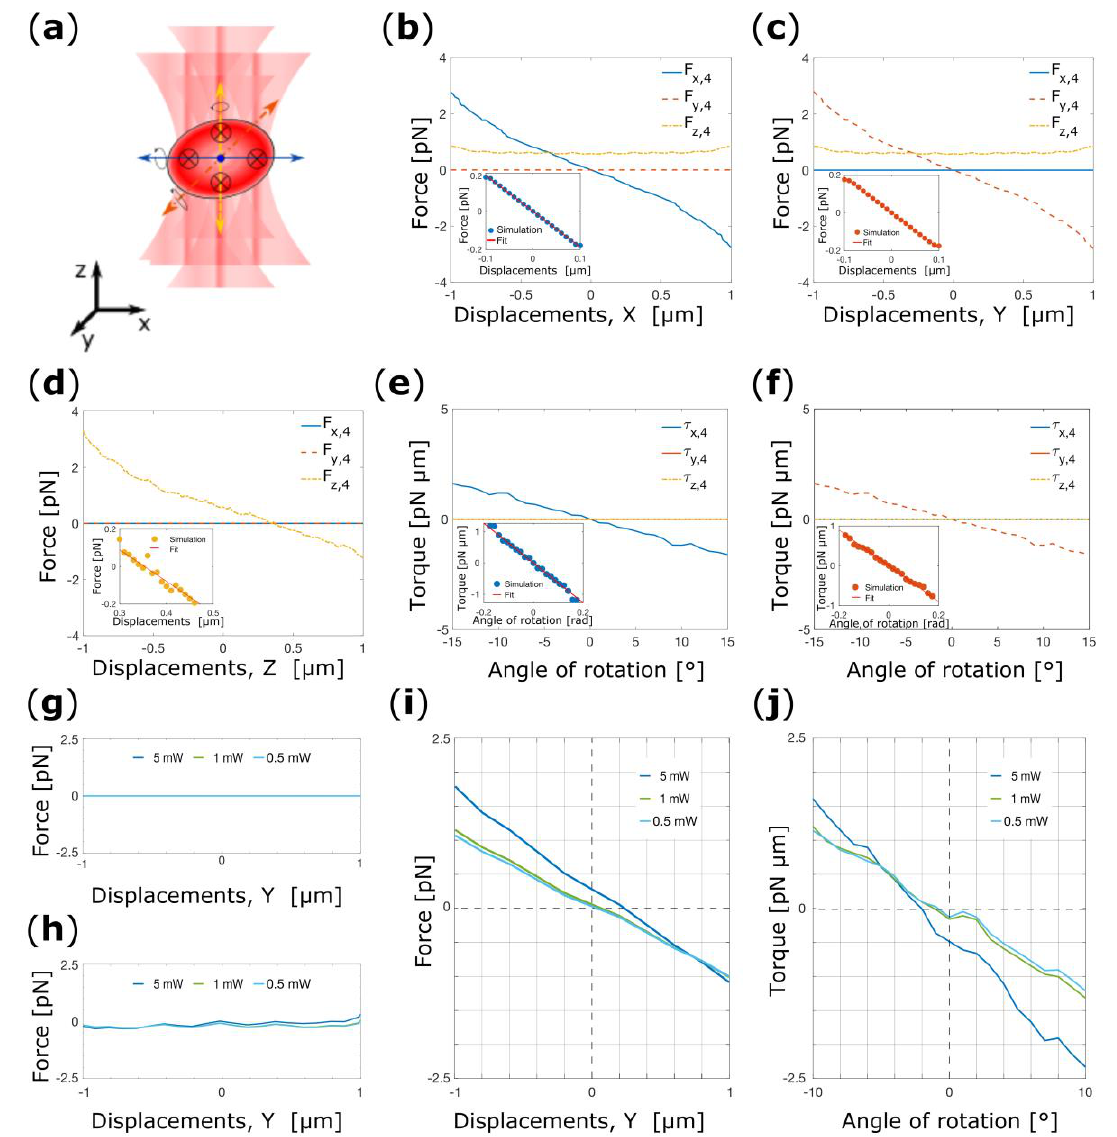
Figure 6. ( a ) Schematic representation of four beam OT. The arrows indicate the possible translations and rotations of the cell. Total optical force acting on the center of mass of the RBC as a function of the cell’s displacements from the center of the trap along x ( b ), y ( c ) and z ( d ). The optical forces are given in terms of the Cartesian components. ( e ) Torque-rotation curves for cell rotation around x ( e ), and y ( f ). In the insets are shown the linear fit to the linear portion of the force-displacements and torque-rotation curve. Force-displacements curves for cell displacements along the x -direction ( g ), z -direction ( h ), and y -direction ( i ) while in ( j ) is reported the torque-rotation curves. In ( g – j ) the power of the beam on the vertex positioned over the y -axis is decreased sequentially from 5 mW to 1